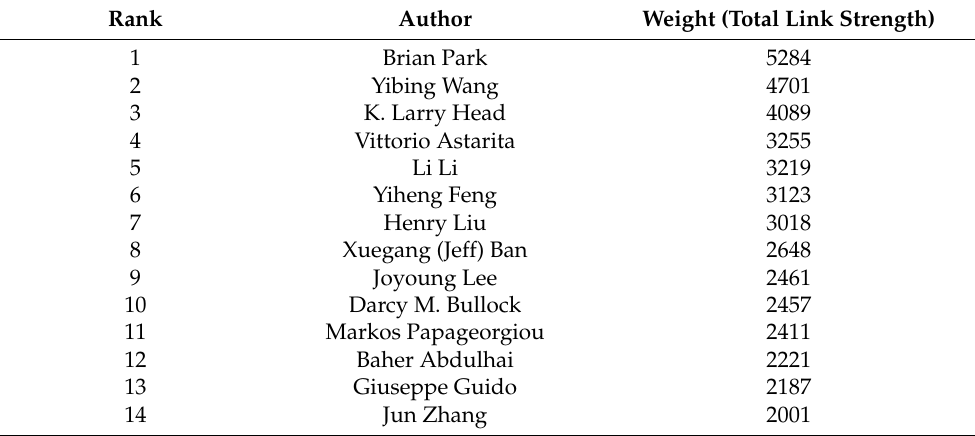
Table 4. Most influential authors after manually resolving name duplications.